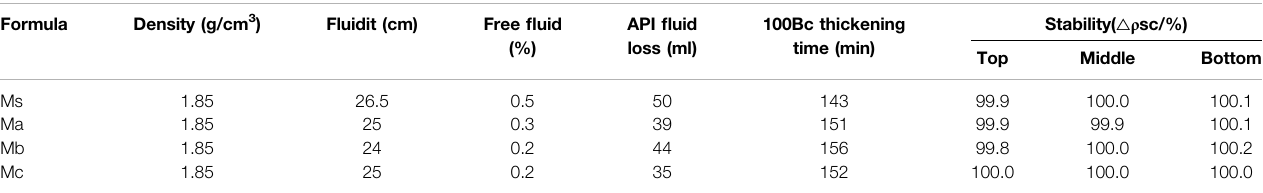
TABLE 3 | Properties of the CAC slurry.